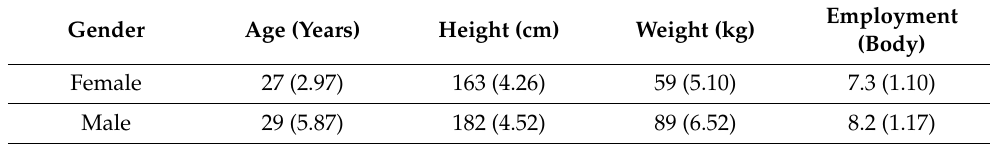
Table 1. Average anthropometric